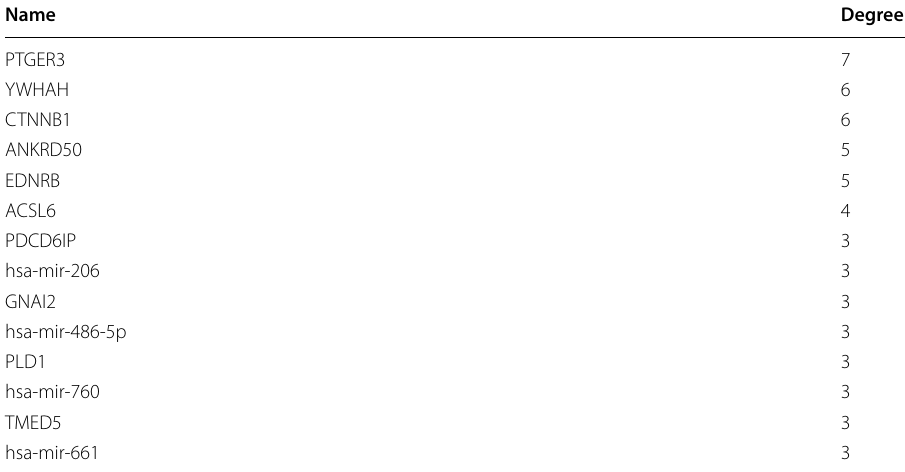
Table 4 The extracted hub genes and mirs nominated for performance evaluation in the chemoresistance process